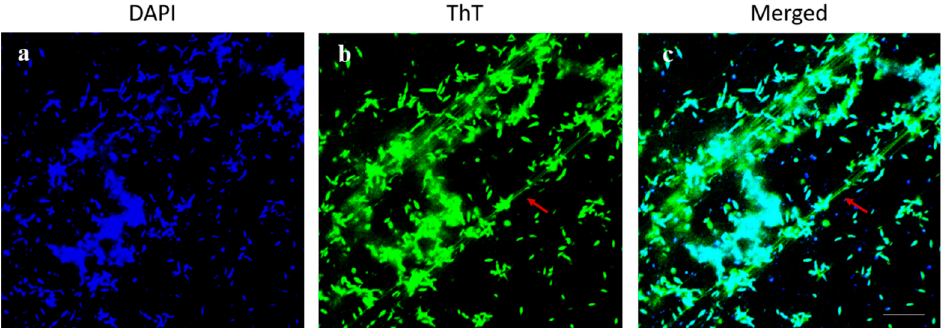
dual fluorescence labelling by confocal laser scanning microscopy (CLSM). ( a – c ) Bacterial cells within the biofilm (4 (cid:48) ,6-diamidino-2-phenylindole (DAPI), blue) and red arrow indicates for amyloid-like